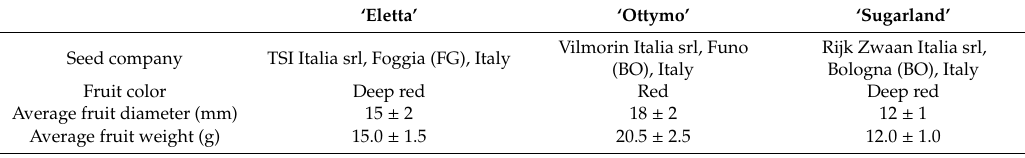
Table 1. Main information and fruit characteristics related to the cultivars selected for the study. ‘Eletta’ ‘Ottymo’ ‘Sugarland’ Seed